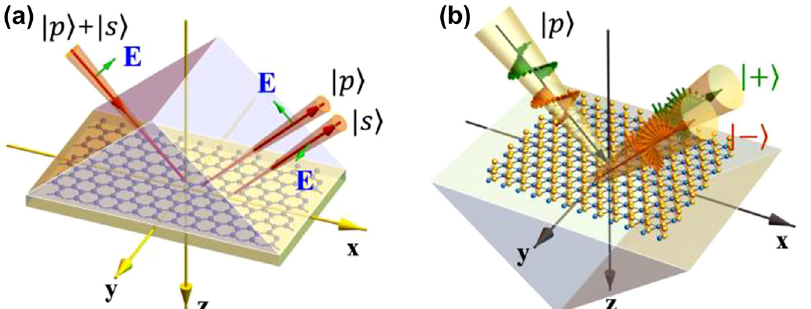
Figure 8: Alternative technique to obtain the optical permittivities of 2D